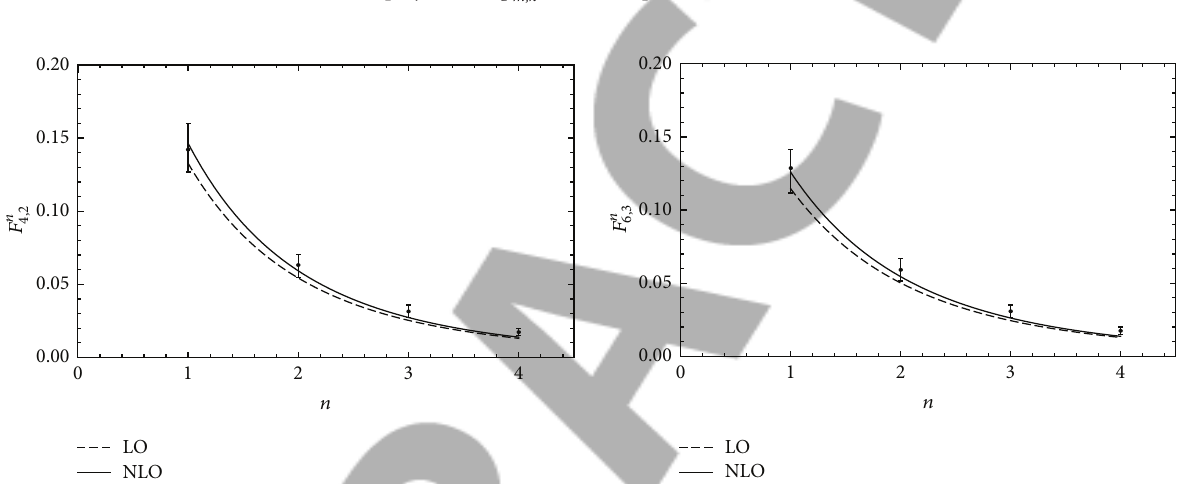
Figure 3: The averaged quantity of the truncated Mellin moment as a function of the truncated moment order, 𝑛 .